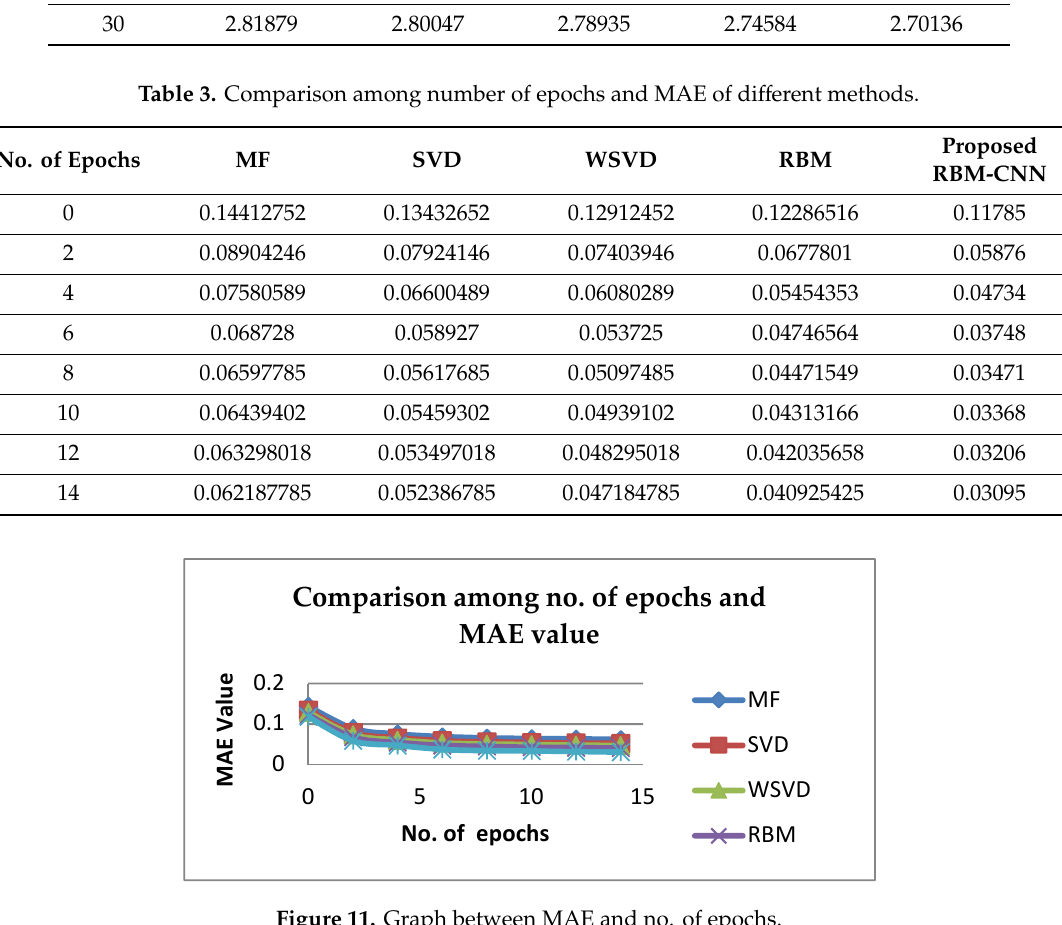
Figure 11. Graph between MAE and no. of epochs.